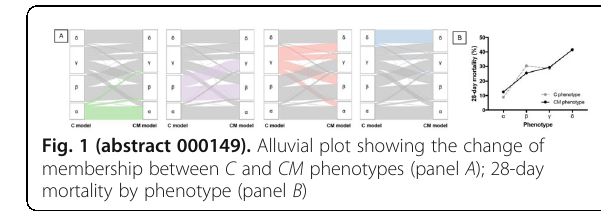
Fig. 1 (abstract 000149). Alluvial plot showing the change of membership between C and CM phenotypes (panel A ); 28-day mortality by phenotype (panel B